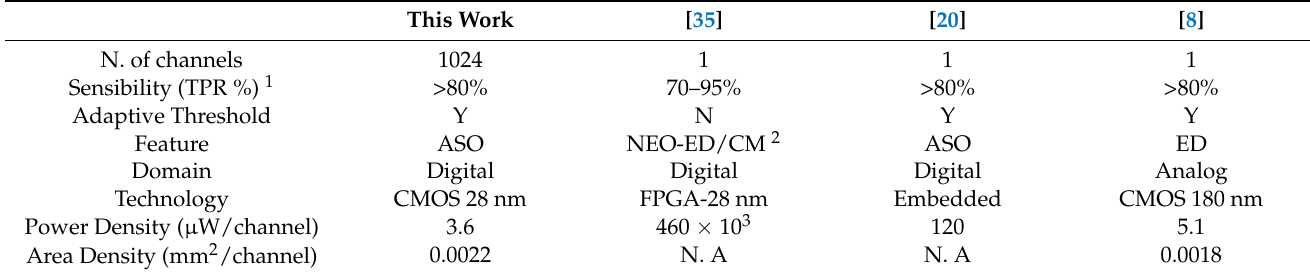
Table 4. Comparison of our proposal with other works present in